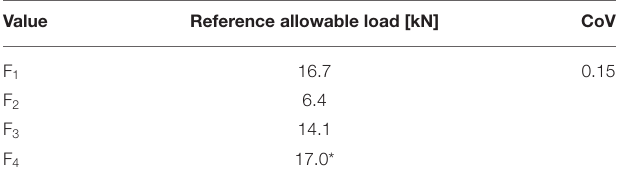
TABLE 5 | Reference ASD loads for bracket-type